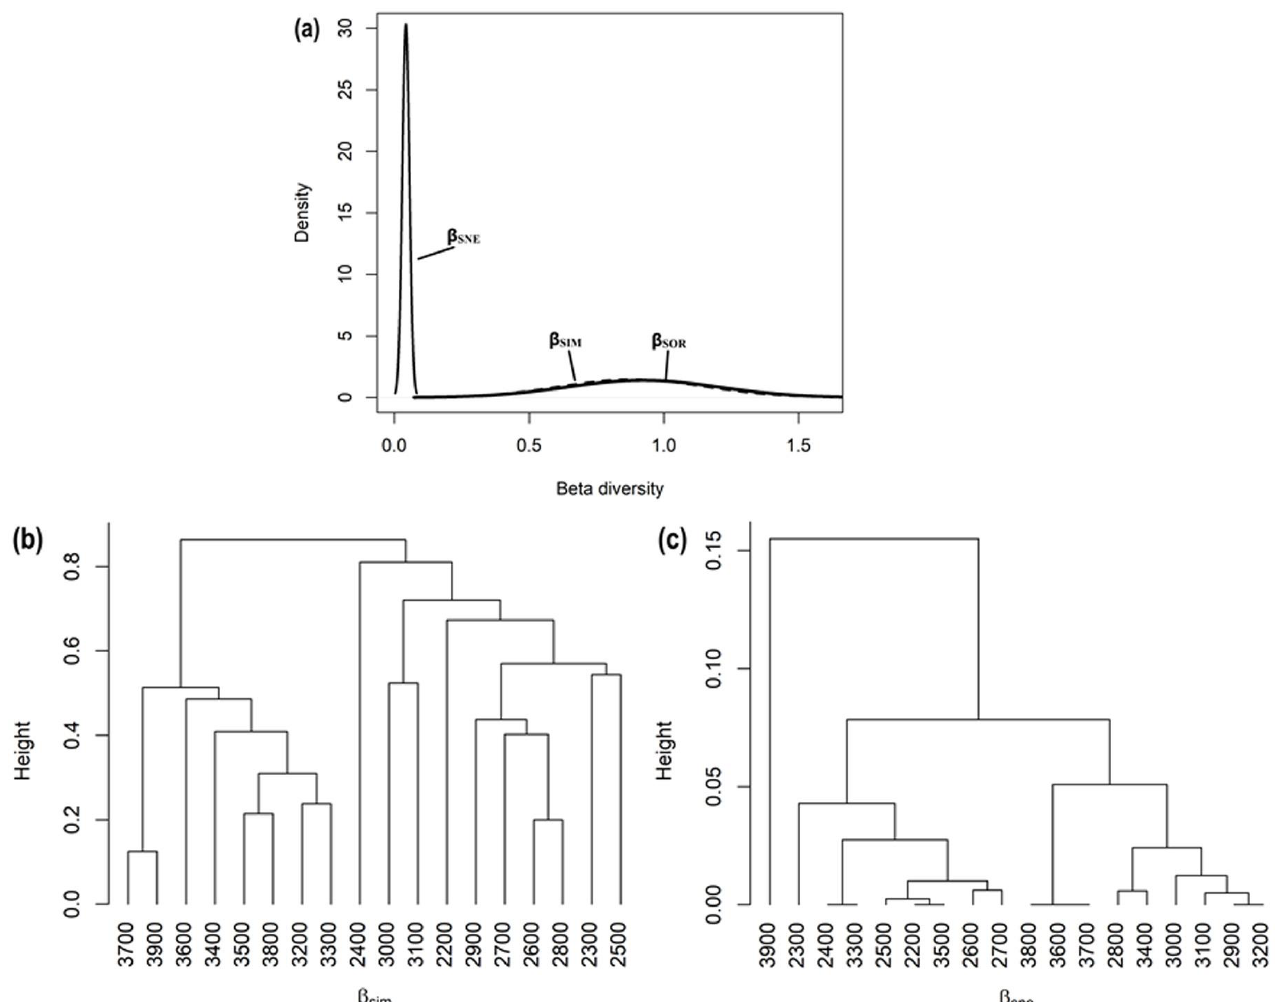
Figure 5. Multiple-site dissimilarities across the studied elevation belts using total plant species composition. ( a ) Partitioning of total dissimilarity ( β SOR : black solid line) into species turnover or replacement ( β SIM : dashed line) and nestedness ( β SNE : grey solid line) components; ( b ) average clustering based on β SIM components of total plant species dissimilarity among the studied elevation belts; and ( c ) β SNE components of total plant species dissimilarity among the studied elevation belts.